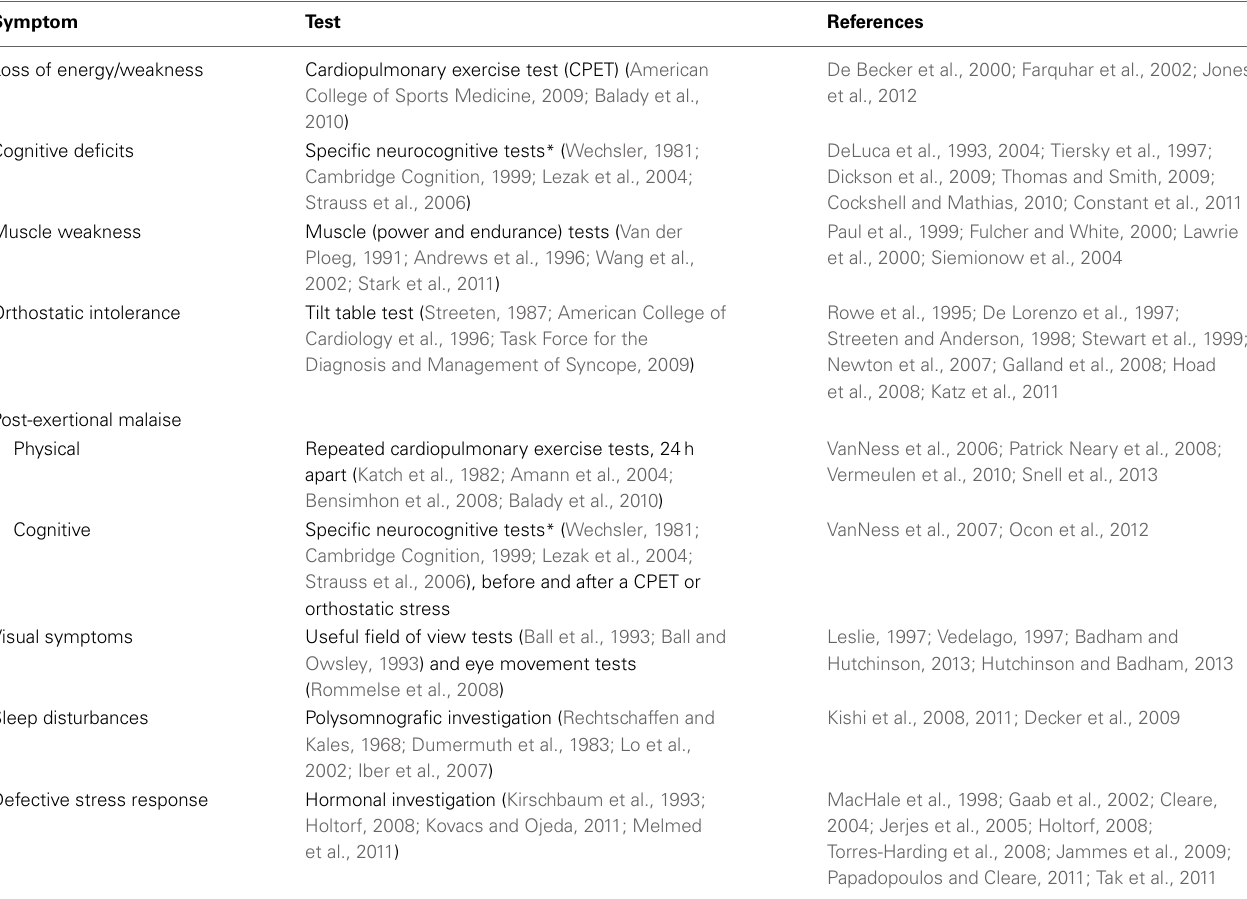
Table 1 | Symptoms and